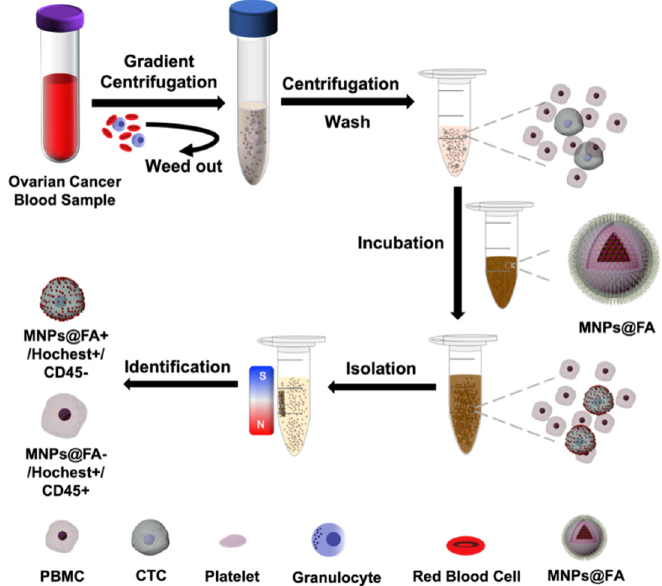
Figure 1. Schematic illustration of the process of CTC separation and identification by folic acid (FA)-modified fluorescent-magnetic nanoparticles (MNPs@FA).